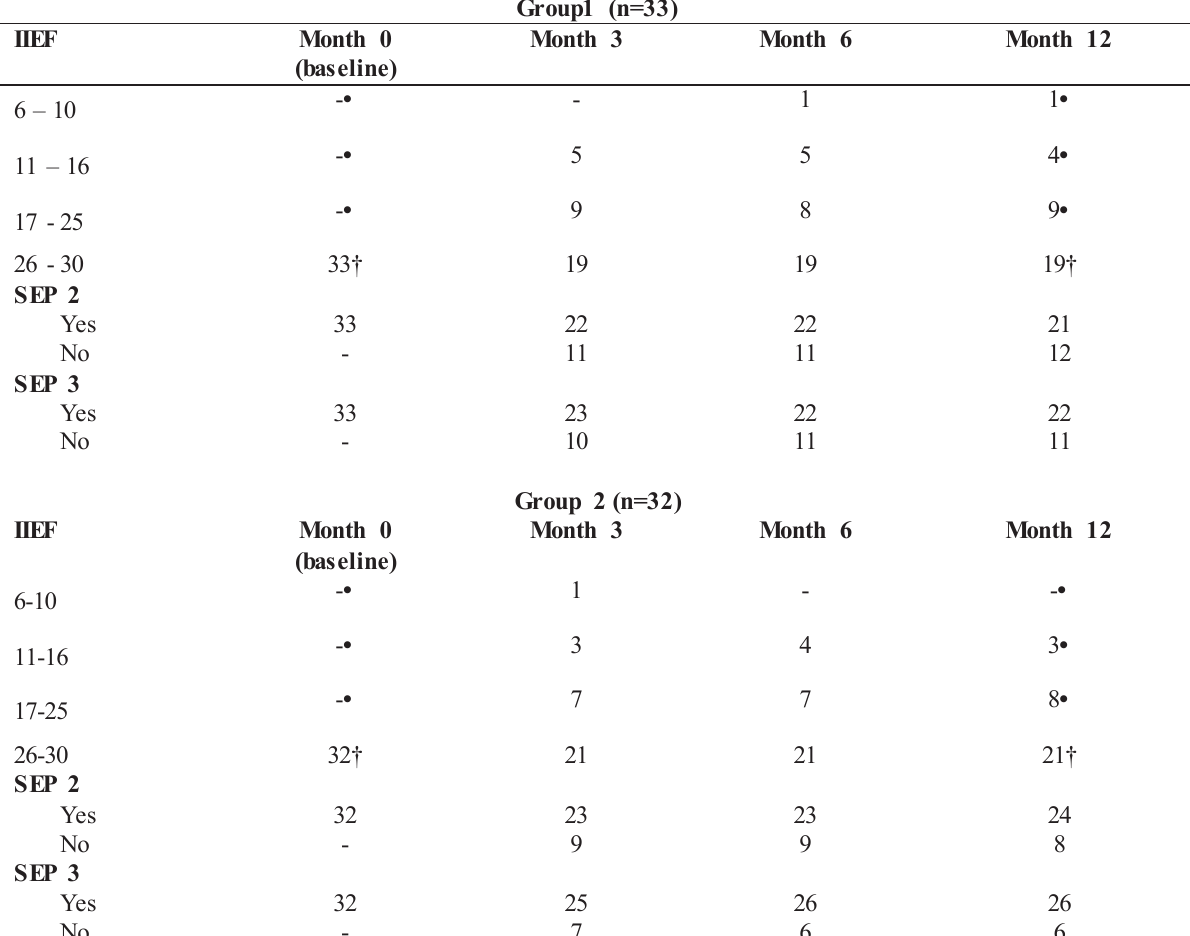
Table 3. Erectile function status of patients in both Table 3 - Erectile function status of patients in both groups.